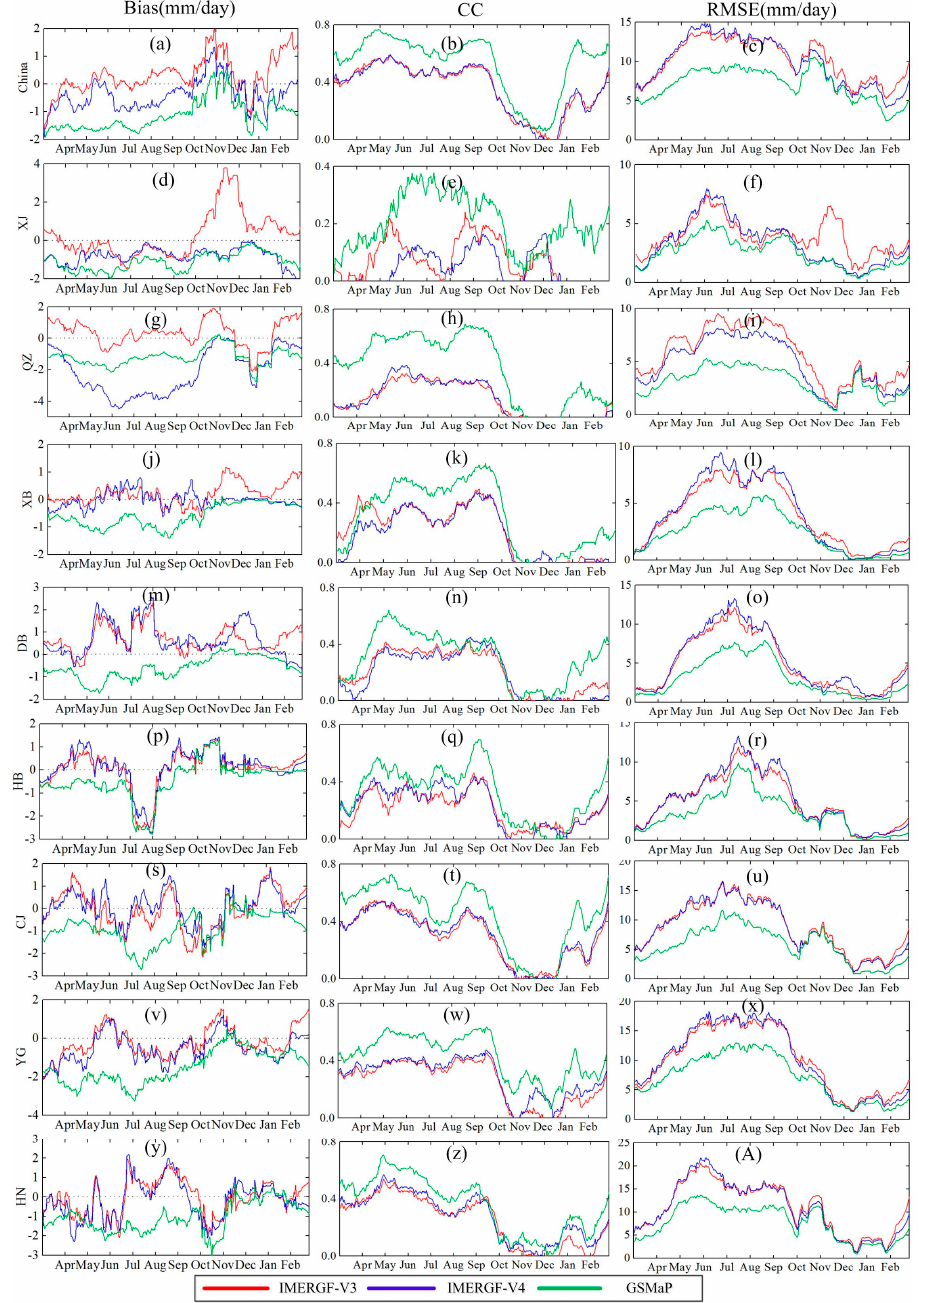
Figure 6. Daily bias, correlation coefficient (CC) and root-mean-square error (RMSE) between CPAP and three satellite-based precipitation products over China and the eight sub-regions from March 2014 to February 2015. ( a – c ) represents the BIAS, CC and RMSE over china. ( d , g , j , m , p , s , v , y ) represents the Bias values over eight sub-regions, ( e , h , k , n , q , t , w , z ) represents the CC values over eight sub-regions, ( f , i , l , o , r , u , x , A ) represents the RMSE values over eight sub-regions, respectively. Only grid pairs with values of both CPAP and satellite-based precipitation above zero are used.